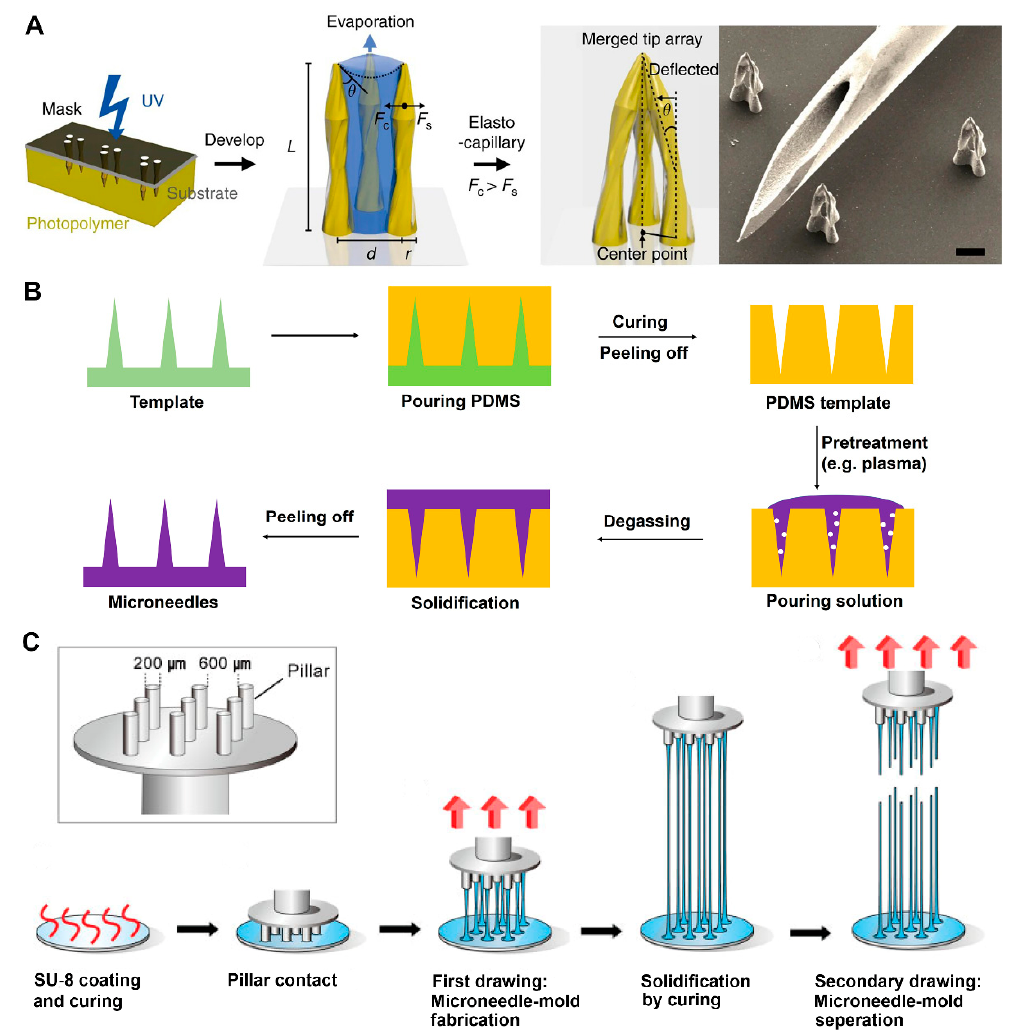
Figure 2. Schematic illustration of fabrication methods. ( A ) Procedure for the fabrication of a hollow MN by photolithography (reproduced with permission from the authors of [91] ). ( B ) Typical process of MN fabrication via micromolding (authors' own work). ( C ) Steps for producing primary MN array by drawing lithography(reproduced with permission from the authors of [88] ). PDMS,